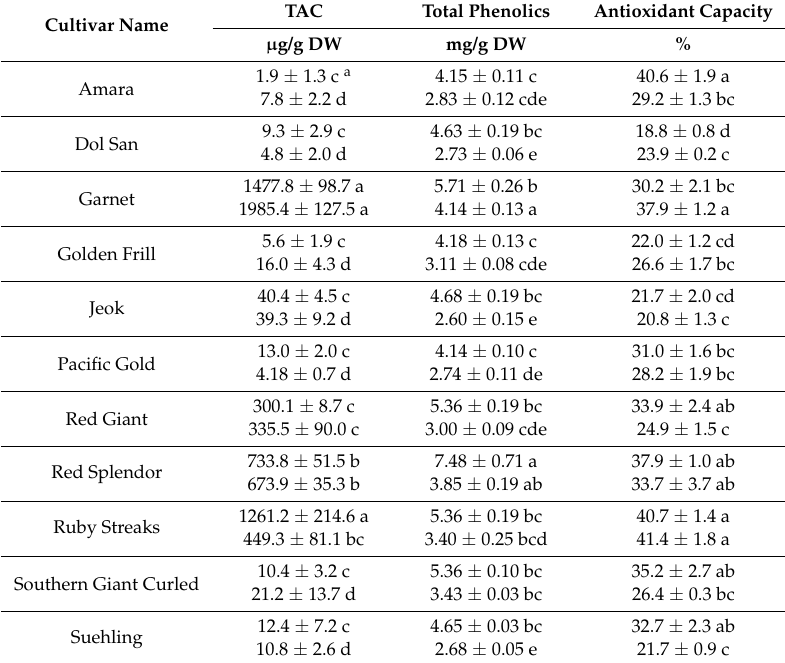
Table 3. Total Anthocyanin Content (TAC), Total Phenolics, and DPPH (antioxidant) concentrations in the mustard at baby leaf (upper values in the cells) and mature (bottom values in the cells)